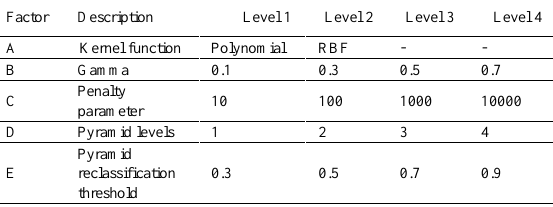
Table 1. Factors and their levels used for optimization in pixel-based and object oriented techniques.